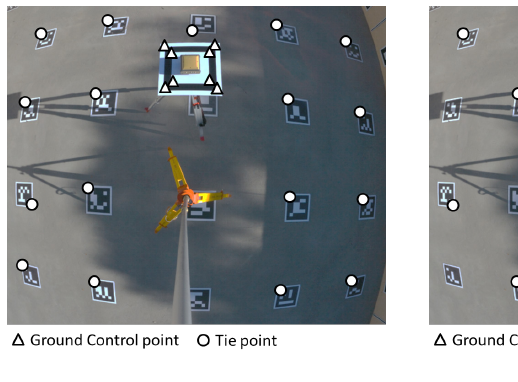
Figure 6. Assessment area with eight control points and varying number of tie